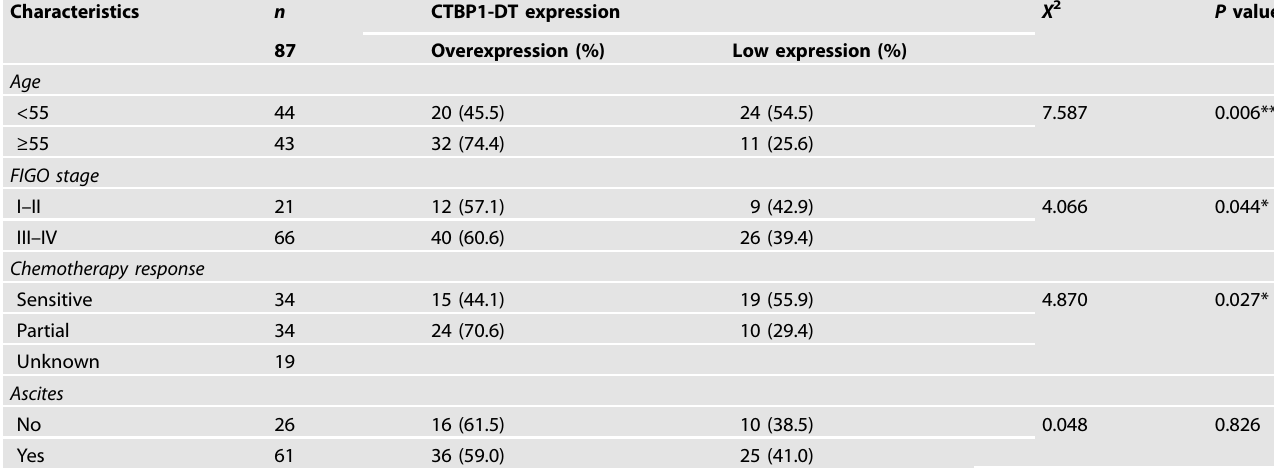
FIGO Federation International of Gynecology and Obstetrics, HGSOC high-grade serous ovarian cancer. LncRNA CTBP1-DT overexpression was signi fi cantly associated with age ( P = 0.006), FIGO stage ( P = 0.044) and chemotherapy response ( P = 0.027) by χ 2 test. * P <0.05, ** P <